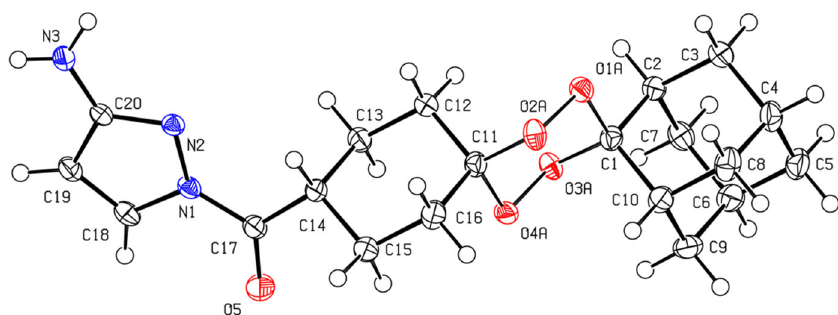
Figure 3. ORTEP drawing of the molecule of (3 ‐ amino ‐ 1H ‐ pyrazol ‐ 1 ‐ yl) ‐ (dispiro[cyclohexane ‐ 1,3’ ‐ [1,2,4,5]tetraoxane ‐ 6’,2’’ ‐ tricyclo[3.3.1.1 3,7 ]decan] ‐ 4 ‐ yl) ‐ methanone (T2 ). Displacement ellipsoids are drawn at the 50% probability level. The tetraoxane group has minor disorder over two alternate chair conformations; for the sake of clarity, only the major conformation is shown.